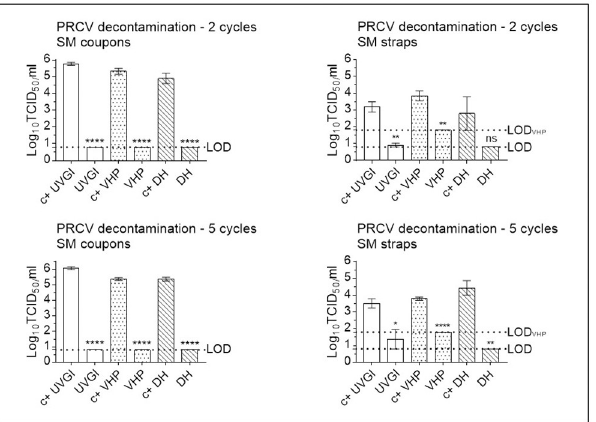
Fig 7. Porcine coronavirus (PRCV) inactivation following multiple cycle surgical mask (SM) decontamination using dry heat (DH), vaporised hydrogen peroxide (VHP), and ultraviolet germicidal irradiation (UVGI). Titrations were performed after two or five (three in the case of DH) decontamination treatments on PRCV-inoculated SM coupons and straps. PRCV infectivity was analysed in swine testicular cells. The cell culture limit of detection (LOD) was 0.80 log10 TCID 50 /mL (6.31 × 10 0 TCID 50 /mL) for all analyses except those concerning VHP-treated SM straps (1.80 log10 TCID 50 /mL (6.31 × 10 1 TCID 50 /mL)). Per decontamination method, nine PRCV-inoculated, decontaminated coupons (n = 9) and three inoculated, decontaminated straps (n = 3) were analysed in parallel to inoculated, untreated, positive control (c+) coupons (n = 9) and straps (n = 3). Mean log10 TCID 50 /mL and standard errors of the means are represented. P-values were computed by using a two-sided independent sample t-test, where ���� P < 0.0001, ��� P < 0.001, �� P < 0.01, � P < 0.05, and ns is P � 0.05.